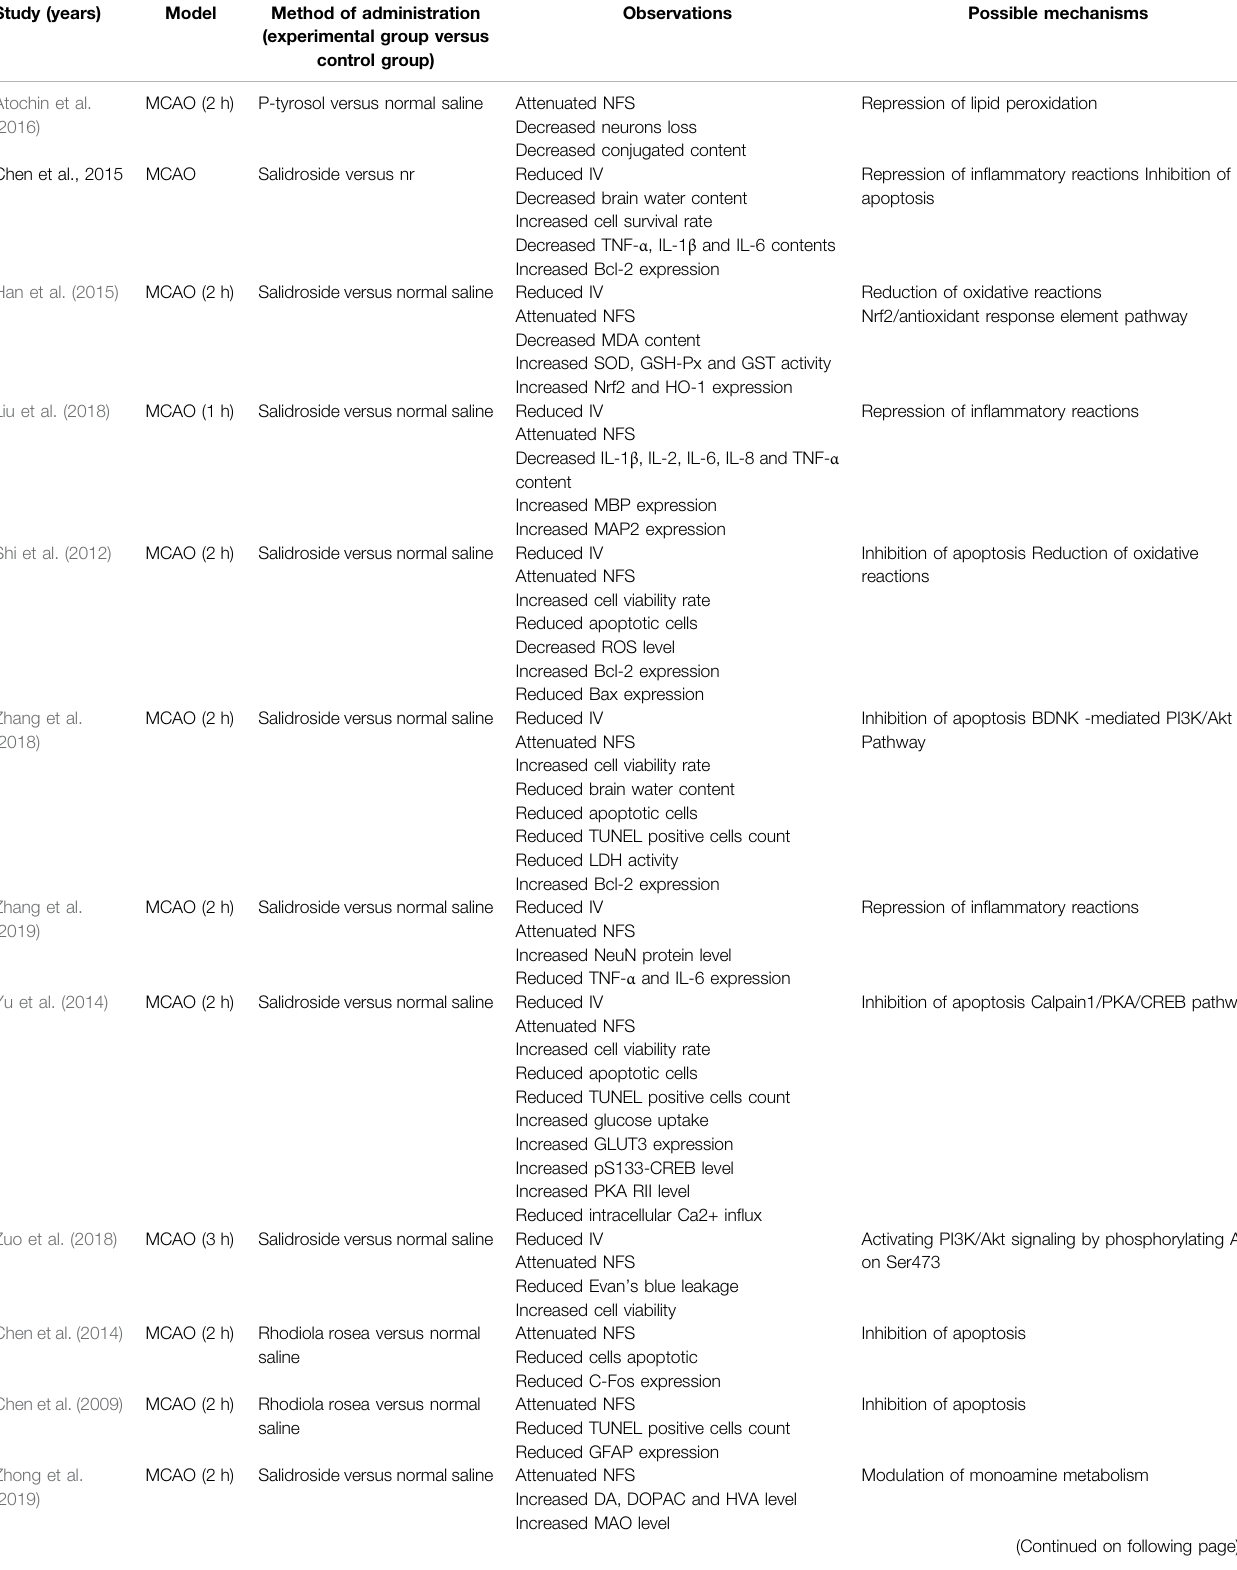
TABLE 3 | Characteristics of mechanism studies of RRC on cognition